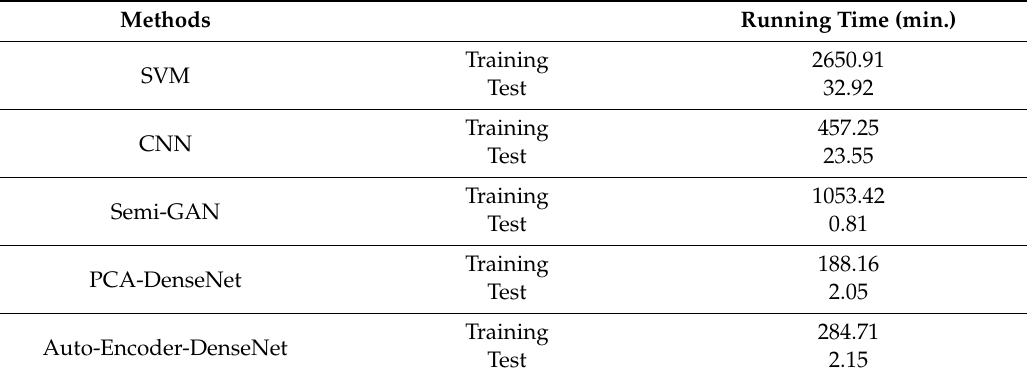
Table 10. Running time of five di ff erent